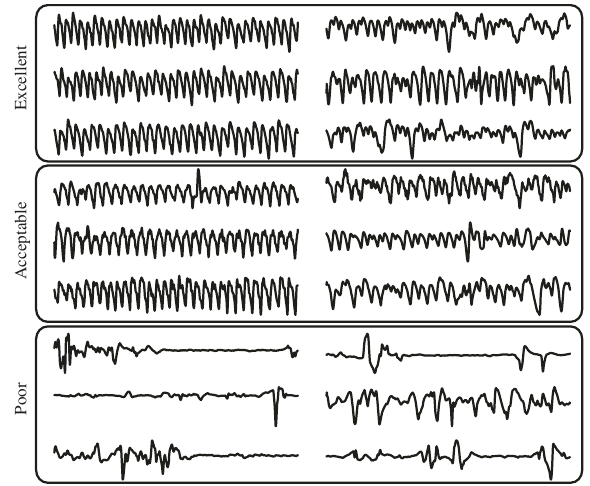
Fig. 2 Example of rhythm and quality assessments of training data. Examples of physiological signals grouped by assessment scores used to train and evaluate the DeepBeat model. From top to bottom, quality assessment scores of excellent, acceptable, and poor. Left column are signals from participants in normal sinus rhythm and the right column are signals from participants in atrial fi brillation.